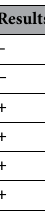
Table 1. Physiological and biochemical characteristics of K. variicola